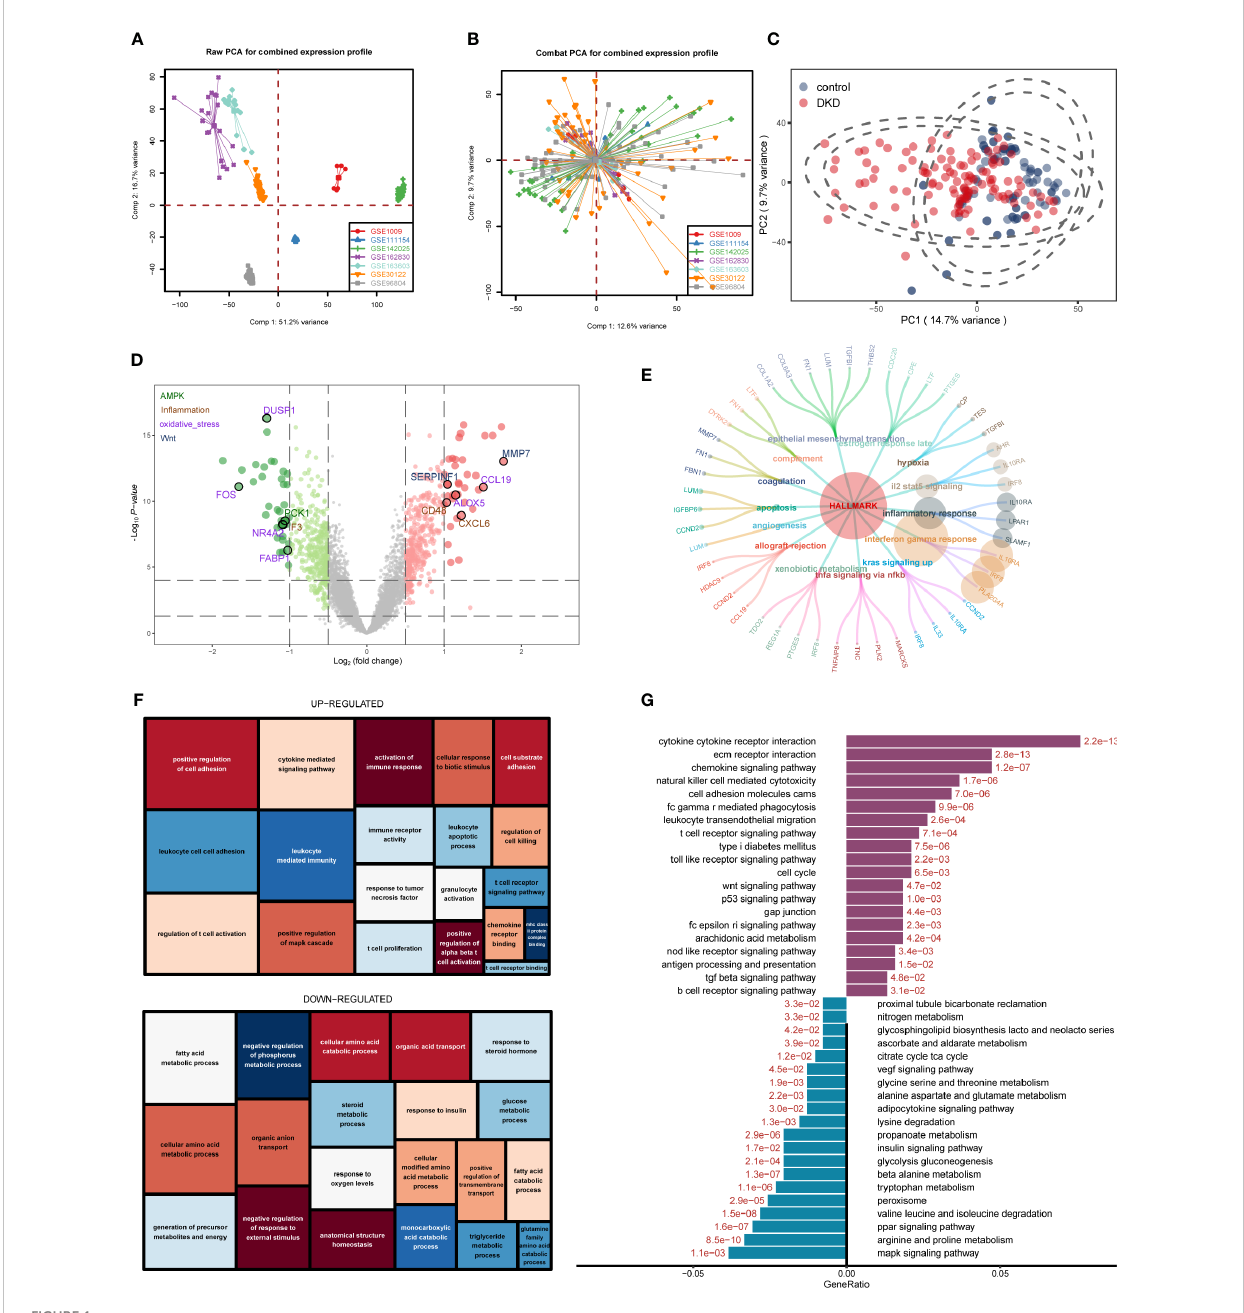
FIGURE 1 Differentially expressed gene (DEG) identi fi cation of diabetic kidney disease (DKD) and enrichment analysis. (A, B) Principal component analysis (PCA) showing the expression distribution of seven DKD datasets before (A) and after (B) batch effect removal. (C) PCA analysis revealed signi fi cant differences in transcriptome levels between DKD samples and normal samples. (D) Volcano plot of differentially expressed genes (DEGs) between DKD samples and normal samples. The DEGs in the pathways related to the occurrence and development of DKD reported in the literature are displayed in different colors. Hallmark gene sets (E) , gene ontology (GO) (F) , KEGG (G) enrichment landscape of the reference gene